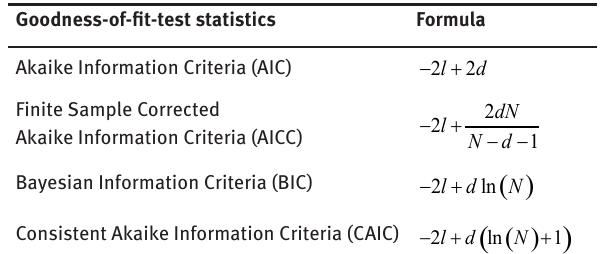
Table 3: Information criteria ( IC ) used as goodness-of-fit-test statistics for comparing different cumulative link functions in the GLM for the ordinal response